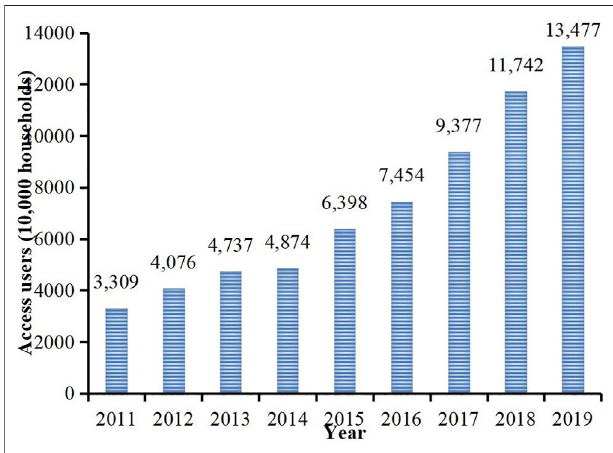
FIGURE 2 | Rural broadband access users from 2011 to 2019 in